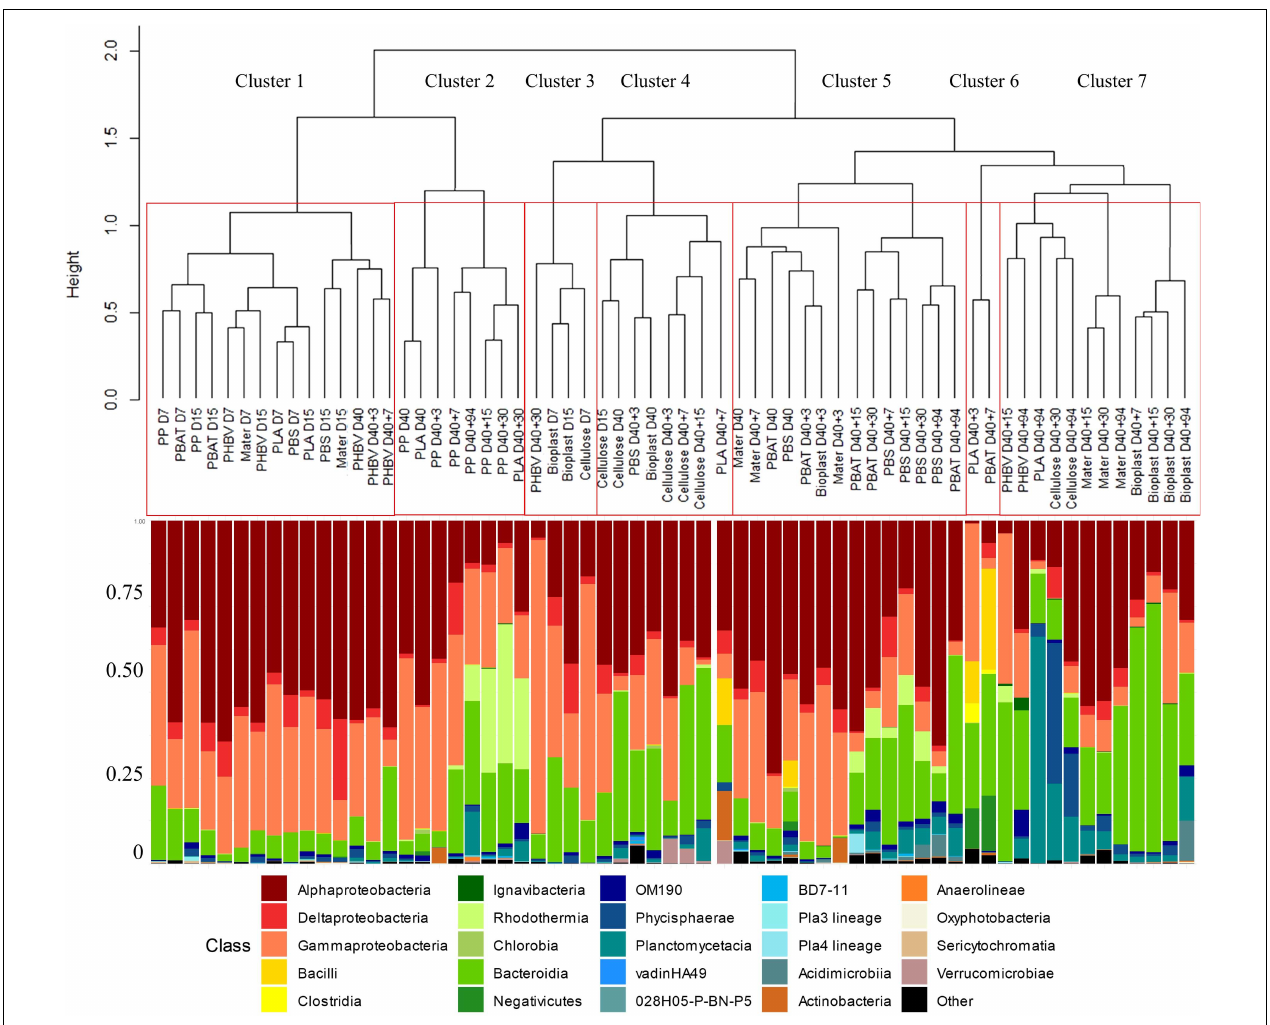
FIGURE 3 | Comparison between hierarchical clustering based on the Bray–Curtis similarity between the temporal dynamic of bacterial communities growing on the eight material types (top part) and their taxonomic affiliation by cumulative charts comparing relative class of abundances (bottom